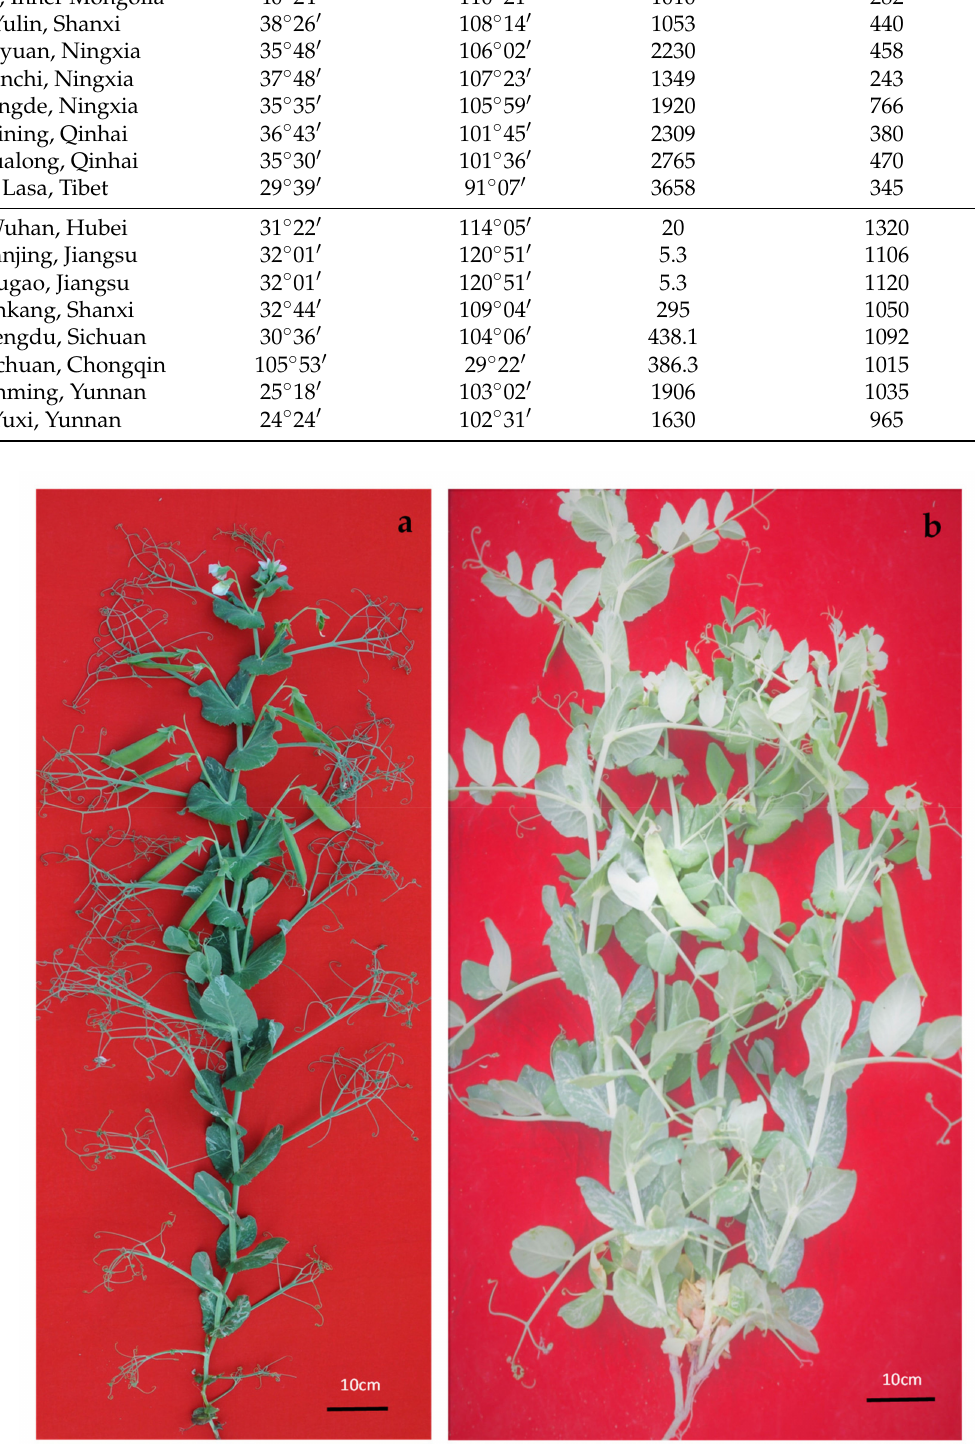
Figure 1. The parent of Longwan No. 6; ( a ) is the female parent (Mp1807), and ( b ) is the male parent